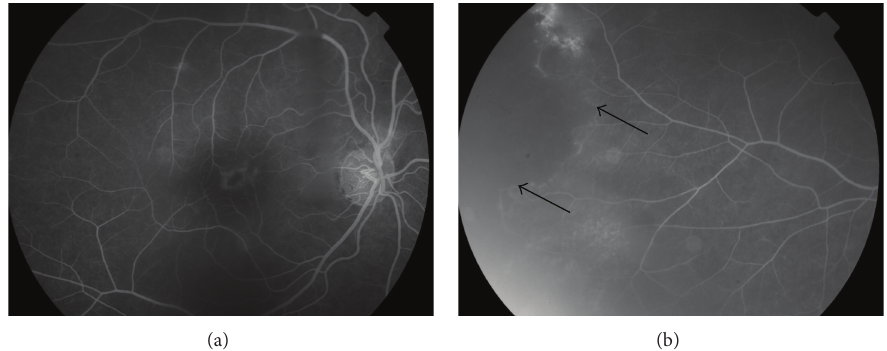
Figure 7: Fundus fluorescein angiography images of a right eye with intermediate uveitis associated with multiple sclerosis; (a) shows fluorescein leakage at the macula secondary to macular edema and (b) peripheral capillary dropout